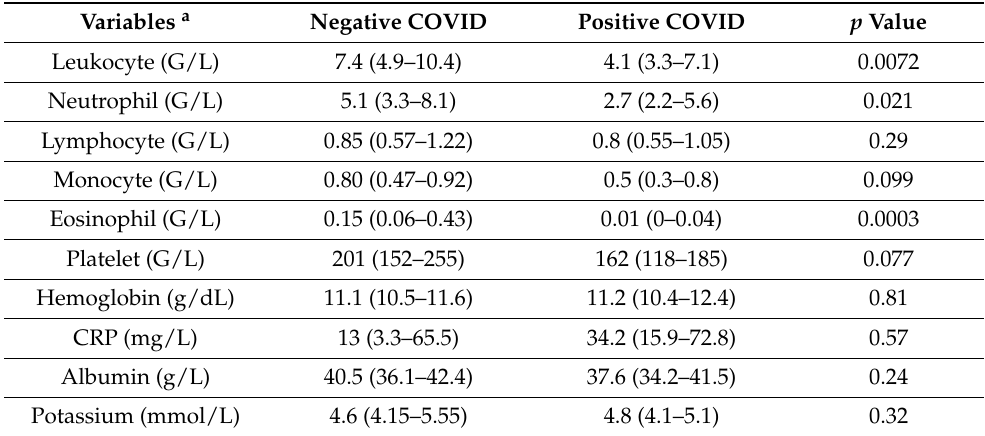
Table 2. Variables the day of COVID-19 suspicion.